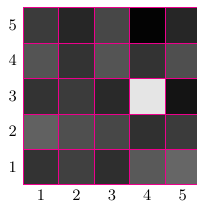
Figure 7: Pixels and pixel coordinates Fig. 7.— Pixels and pixel coordinates The brightest pixel in the 5 × 5 array would have the coordinates (4 , 3), since it is in the fourth column from the left, and in the third row from the bottom. (Beware, other conventions exist! Some count rows from the